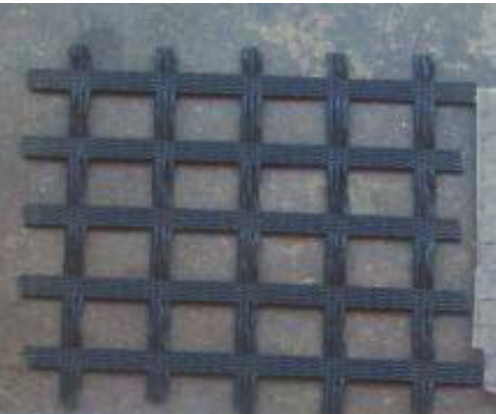
Figure 5: Netlon 121 CE,